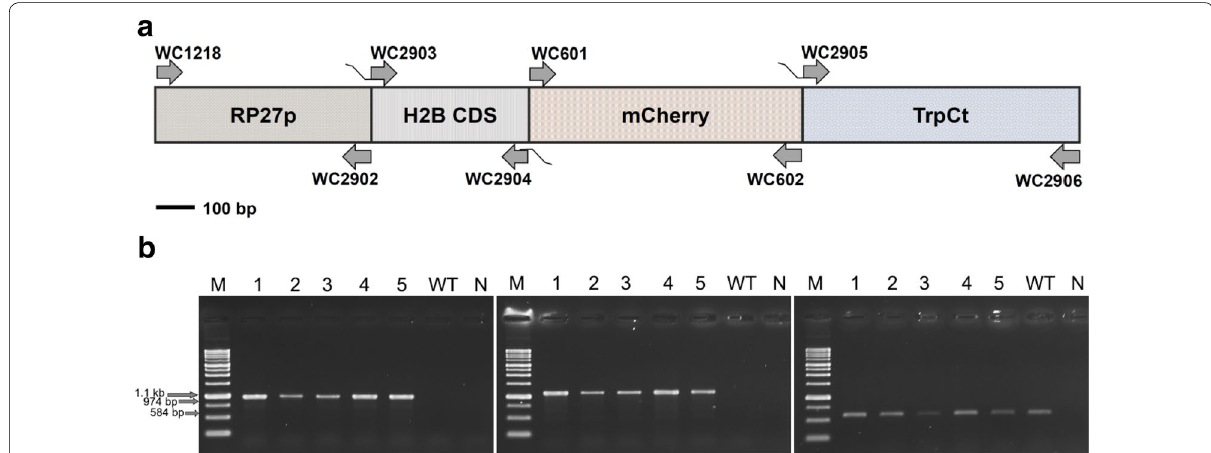
Fig. 1 Generation of fluorescently labeled S. fimicola strains. a Schematic presentation of the plasmid construct used to generate histone H2B‑mCherry‑labeled strains. b PCR was used to verify the successful generation of the H2B‑mCherry‑labeled strains. The plasmid construct was ectopically integrated into the S. fimicola wild type strain (WT: BCRC33665). The transformants and wild‑type strain are shown in Lanes 1–5 and WT, respectively. Amplification with primer pairs WC1218/WC2904 (left), WC2903/WC602 (middle), and ITS1/ITS4 (right) generated fragments of 974 bp, 1.1 kb, and 584 bp,